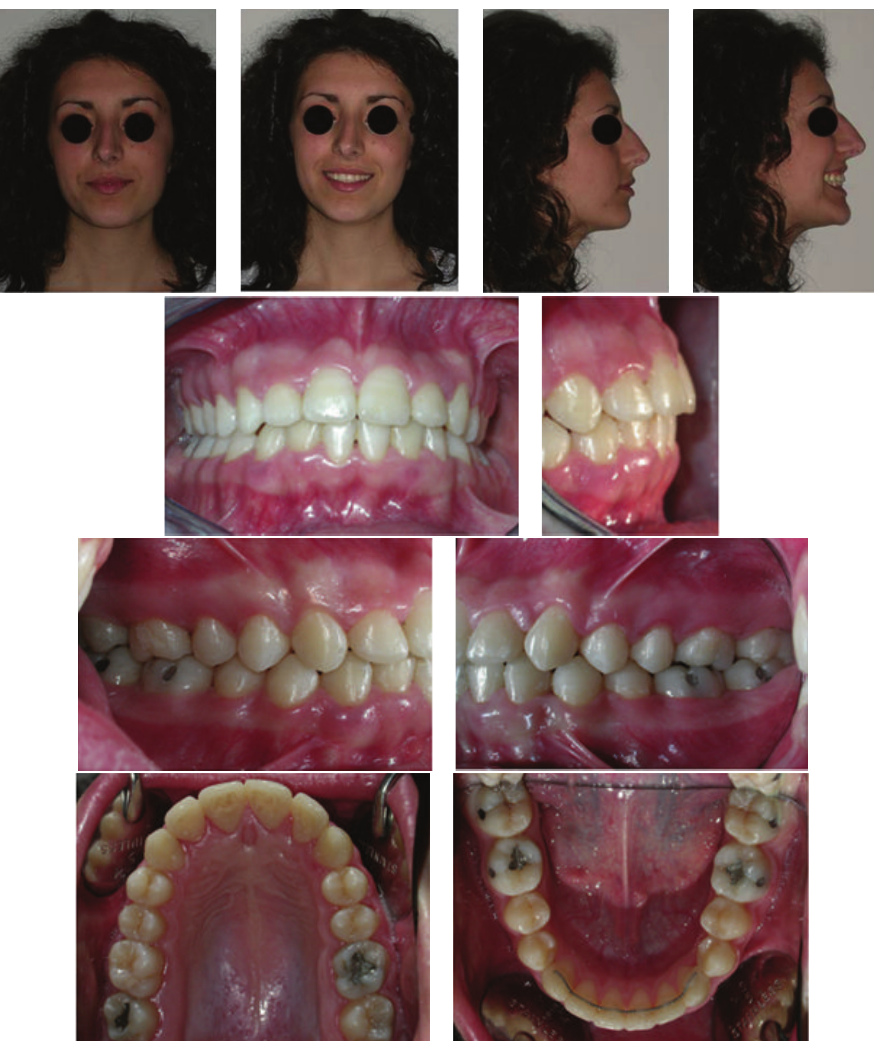
Figure 8: Extraoral and intraoral photographs after